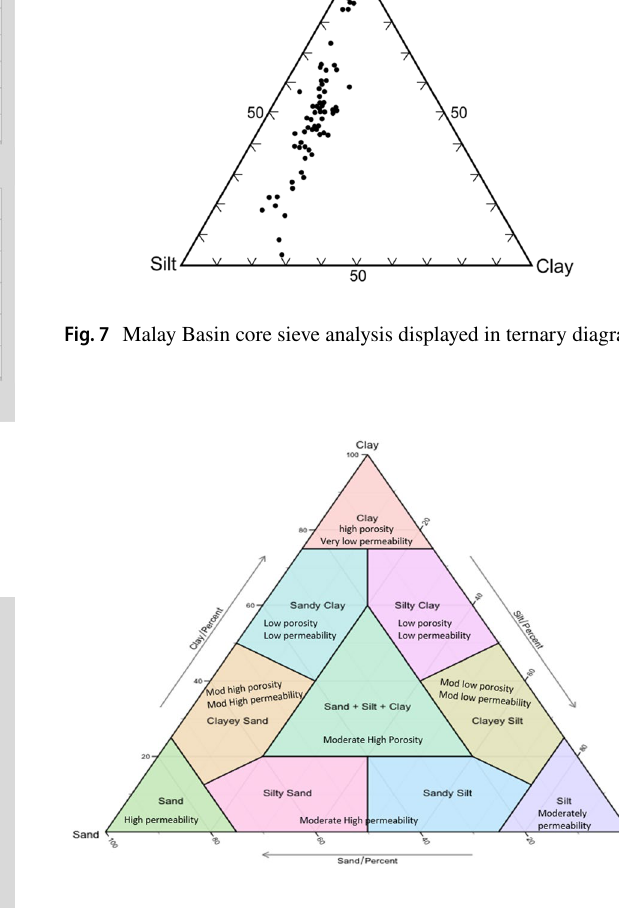
Fig. 8 Shepard ternary